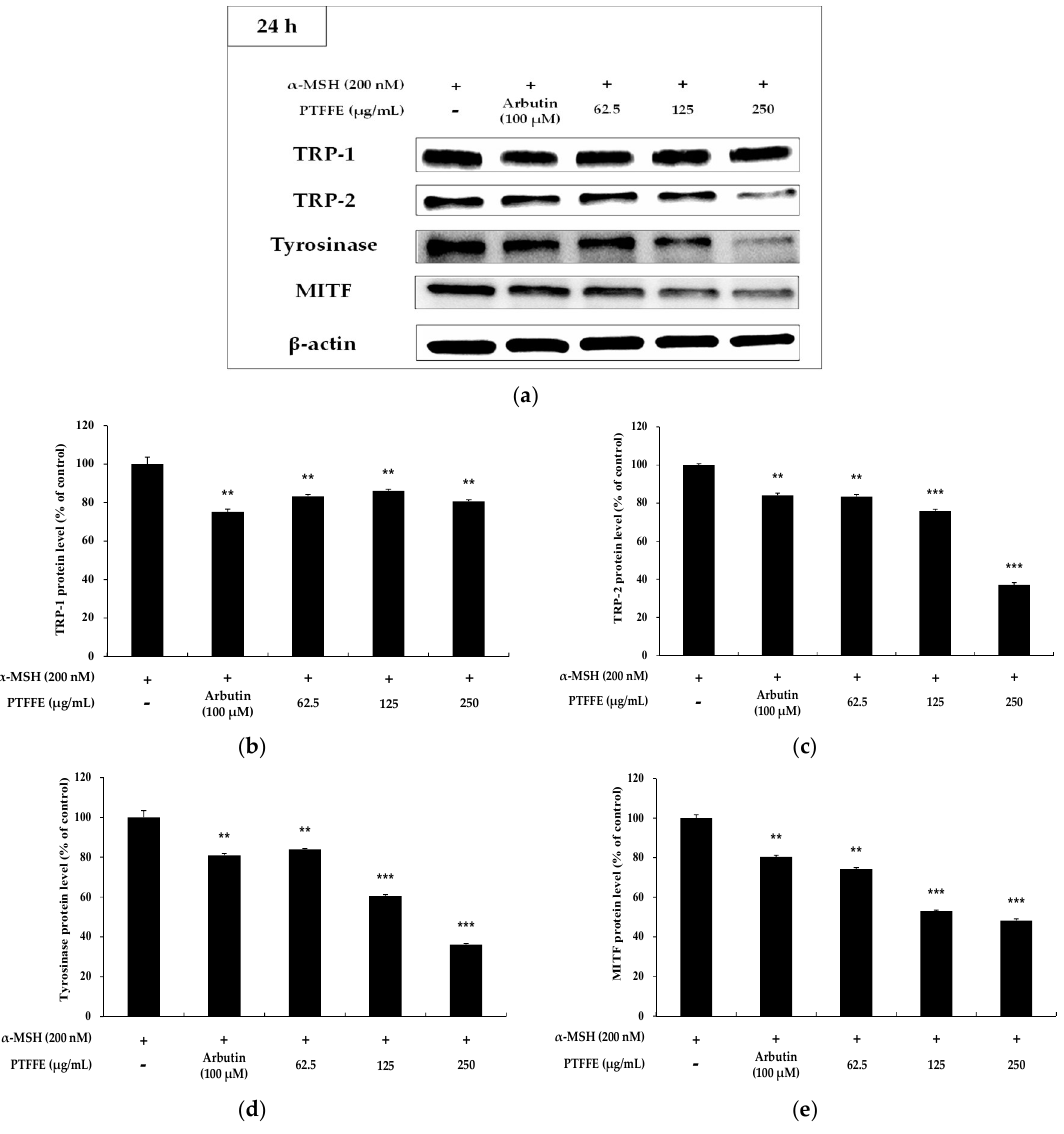
Figure 4. Effects of PTFFE on TRP-1, TRP-2, tyrosinase and MITF expression in B16F10 cells. Cells were treated with the indicated concentrations of PTFFE for 24 h. Protein levels were determined by western blotting. ( a ) Western blotting results and protein levels of ( b ) TRP-1, ( c ) TRP-2, ( d ) tyrosinase and ( e ) MITF. Results are expressed as percentages of the positive control. The data are presented as the mean ± SD of at least three independent experiments. ** p < 0.01, *** p < 0.001.